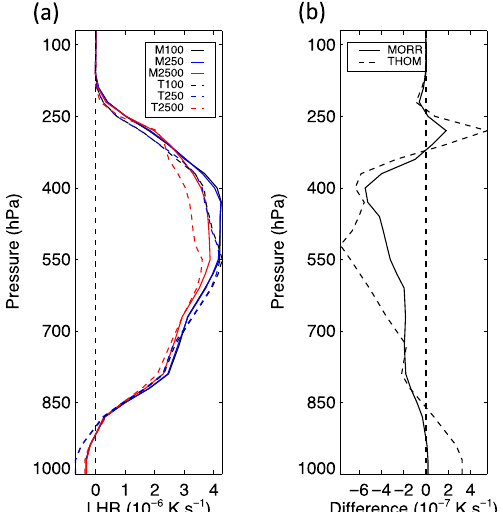
Figure 10. Idealised supercell: (a) vertical profiles of domain-mean total latent heating rate (LHR) over the 2h of the supercell simula- tion for SUPER-MORR and SUPER-THOM for CDNC values of 100, 250 and 2500cm − 3 . (b) Difference in the total latent heating contributions over the 2h of the supercell simulation for SUPER- M2500 minus SUPER-M100 and SUPER-T2500 minus SUPER-